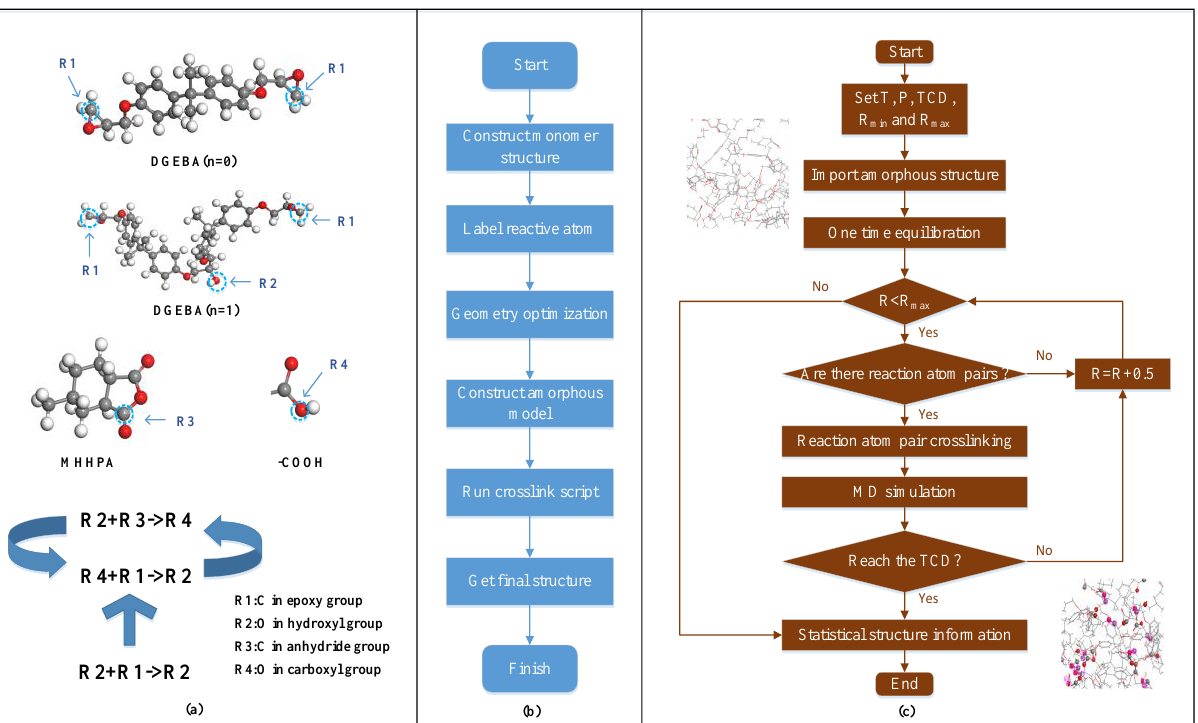
Figure 3. Simulation of epoxy resin crosslinking process ( a ) Atomic calibration names and reaction rules ( b ) Flow chart of structure construction ( c ) Flow chart of crosslinking script and partial structure before and after crosslinking [66].